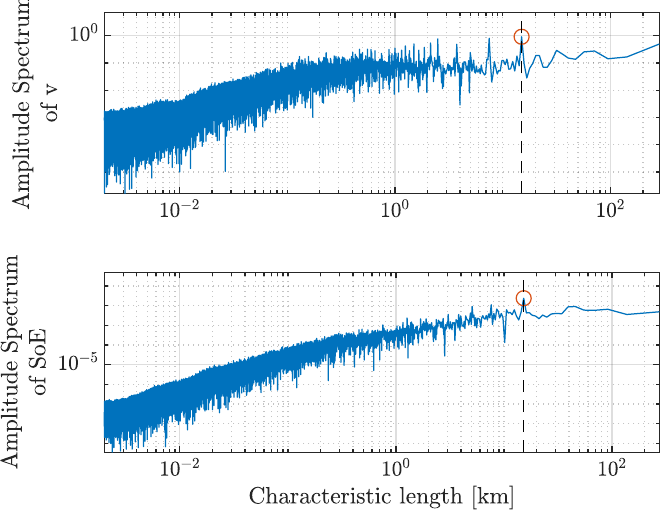
Figure 4. Distance-based Fourier transform of the vehicle speed and optimal SoE profiles during the bus duty cycle. Circles represent the maximum amplitude while the dashed black line shows the characteristic length of a